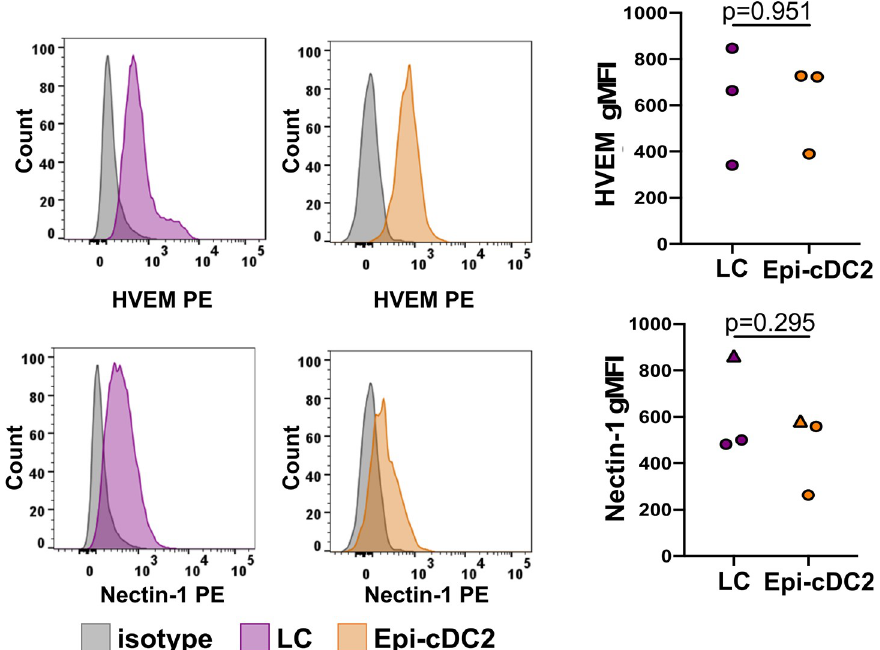
Fig 5. LCs and Epi-cDC2s both express HSV-1 entry receptors HVEM and nectin-1. Epidermal MNPs were isolated from human abdominal or foreskin epidermis and labelled for flow cytometry as in Fig 2, as well as with antibodies to HVEM or nectin-1. The surface expression of HVEM and nectin-1 on LCs (purple histograms) and Epi-cDC2s (orange histograms) is shown in a representative donor. Mean receptor expression (gMFI) is graphed for LCs (purple) and Epi-cDC2s (orange). Circles indicate abdominal skin, triangles indicate foreskin. Two-tailed paired t-tests were used to compare the gMFI of HVEM or nectin-1 expression in LC and Epi-cDC2s, n = 3.